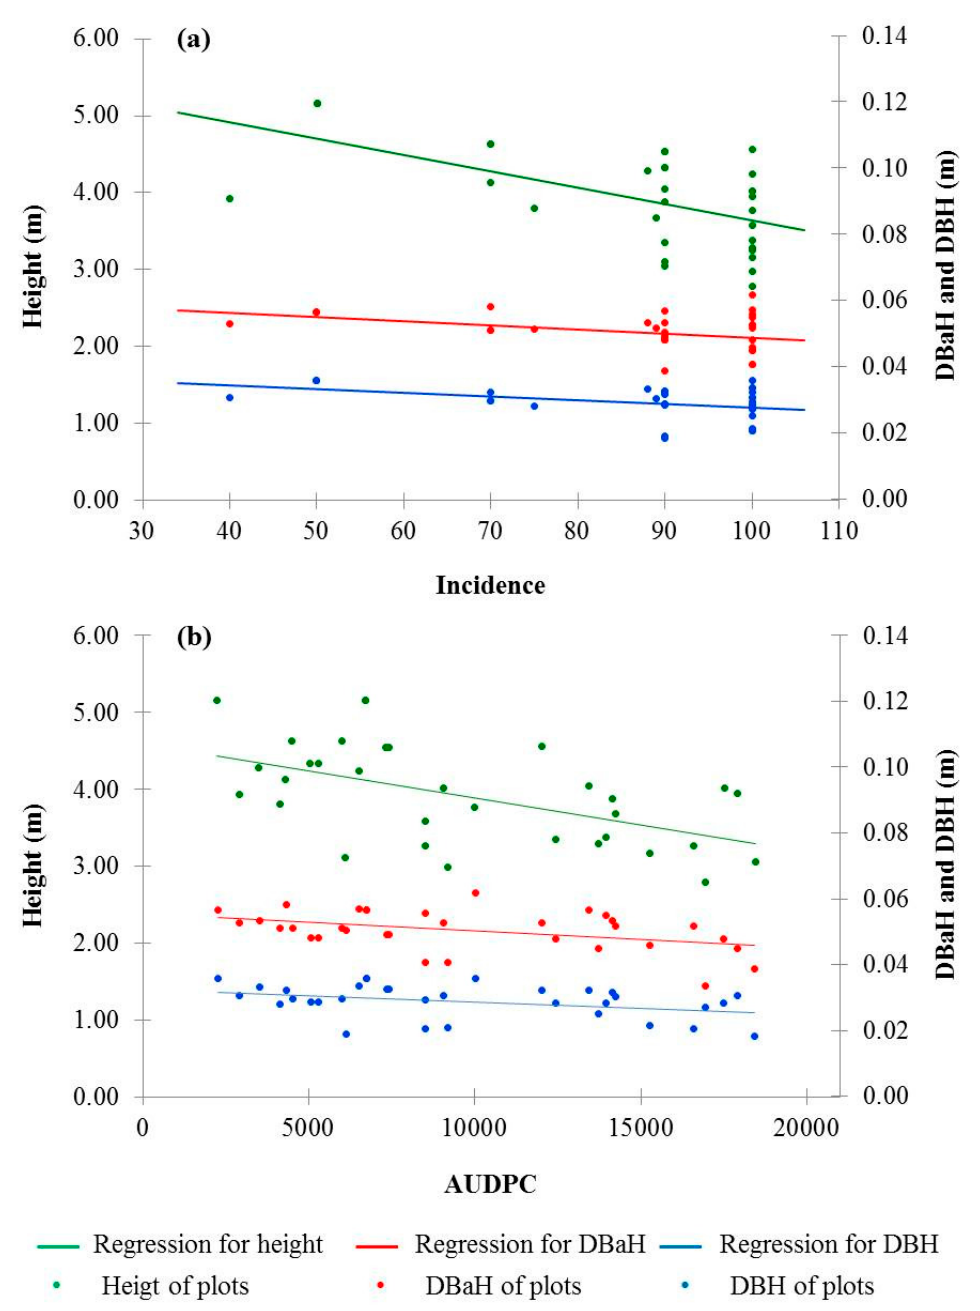
Figure 4. Growth variables (Height; DBaH; DBH) as a function of incidence ( a ) and AUDPC ( b ) of bacterial leaf blight. DBaH: diameter at base height; DBH: diameter at breast height; AUDPC: area under the disease-progress curve.